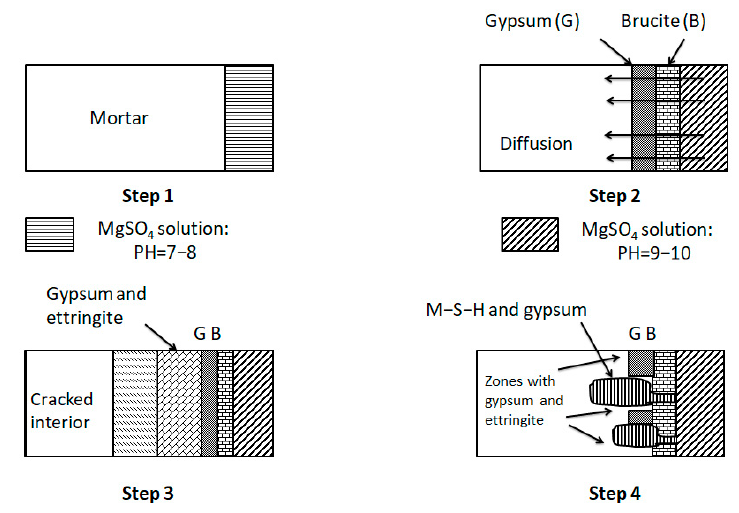
Figure 14. Mechanism of magnesium sulfate attack [50].